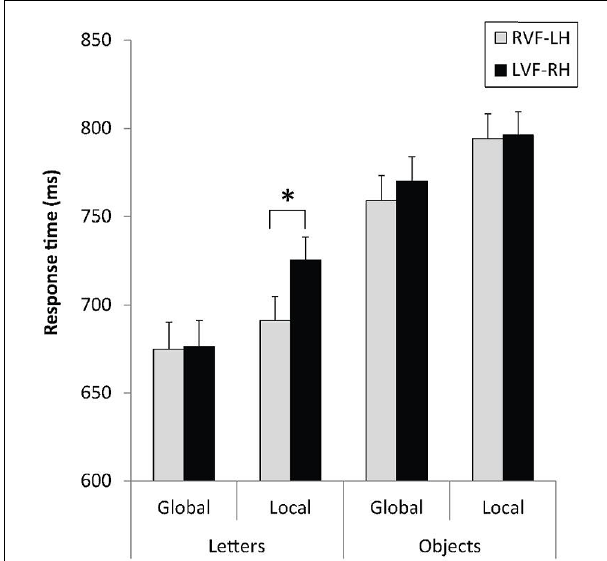
FIGURE 3 | Mean response times and standard errors for letter-based and object-based hierarchical stimuli displayed to the right (RVF-LH) or left visual field (LVF-RH), as a function of the level of the target (global, local). * p <